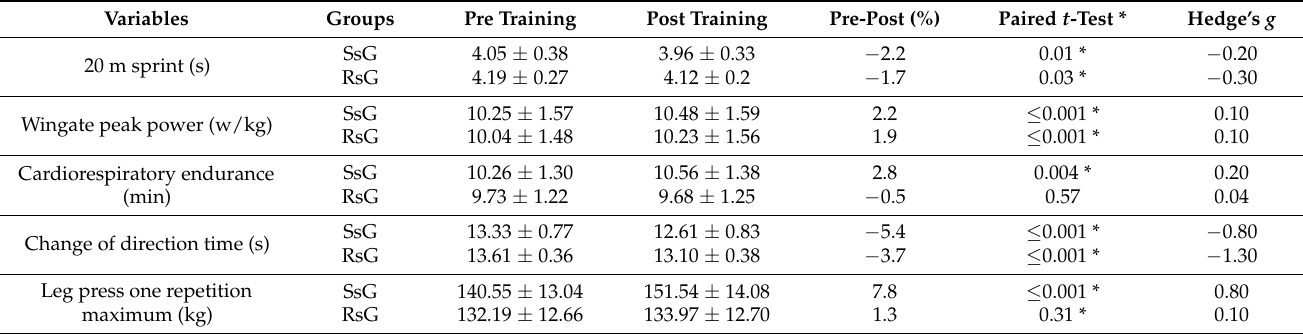
Table 4. Effects of 8 weeks of plyometric jump training conducted on sand (SsG, n = 8) compared to a rigid surface (RsG, n = 9) on female volleyball players’ physical